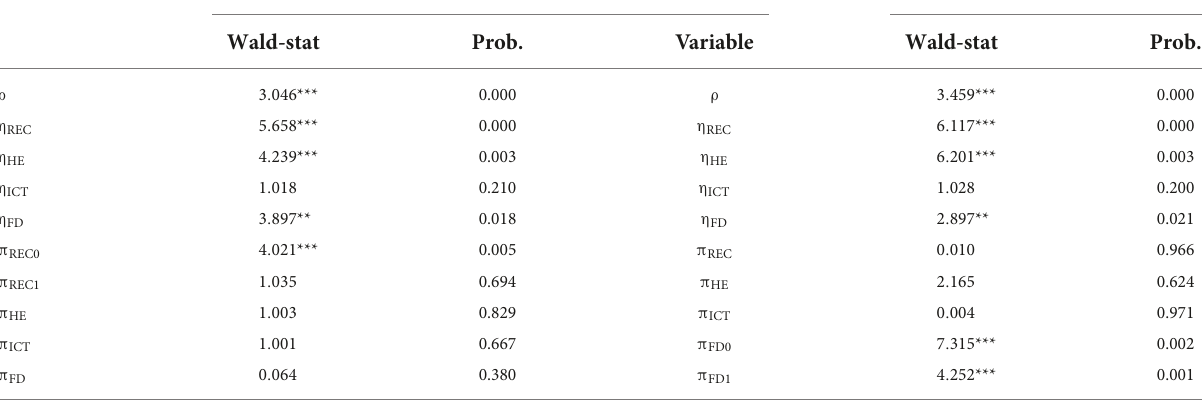
TABLE 6 Wald test result.